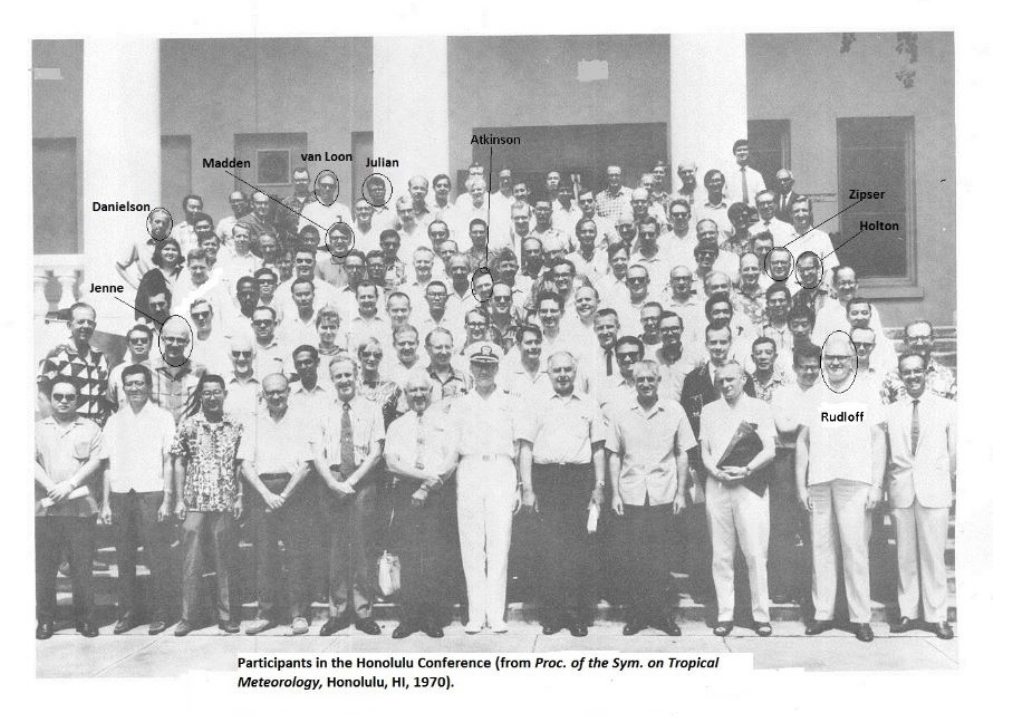
Figure 3. Participants of the Honolulu Tropical Meteorology Conference in 1970 (photo credited to the American Meteorological Society and World Meteorological Organization, 1970). The key to all individuals in the photo can be seen in the AMS/WMO reference or in the Bulletin of the American Meteorological Society supplementary material (Madden, 2019).